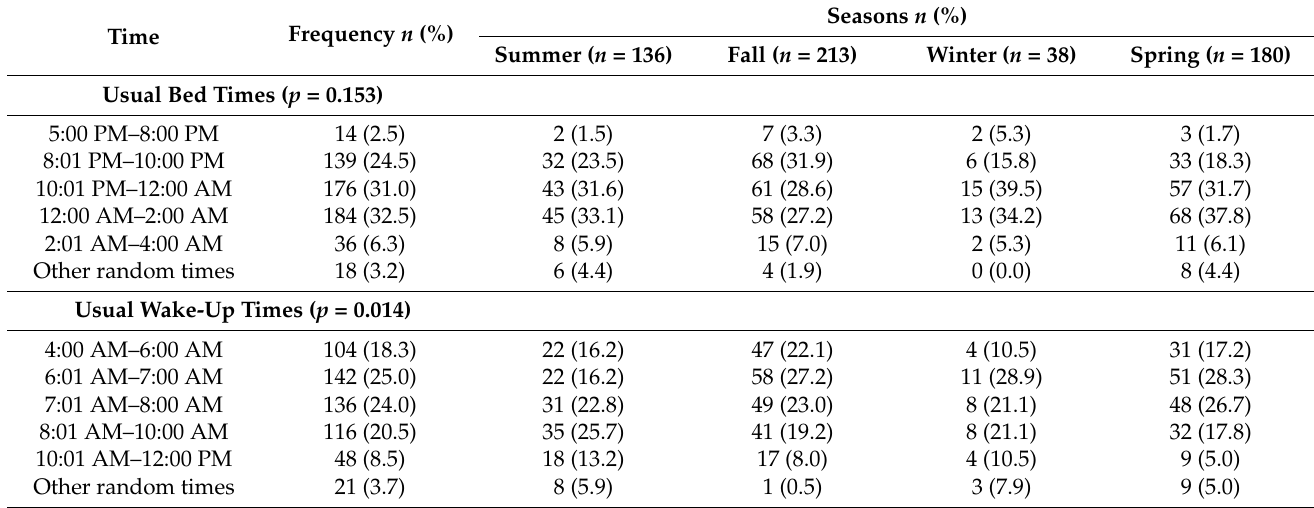
Table 1. Sleeping and wake-up times by seasons ( n = 567).